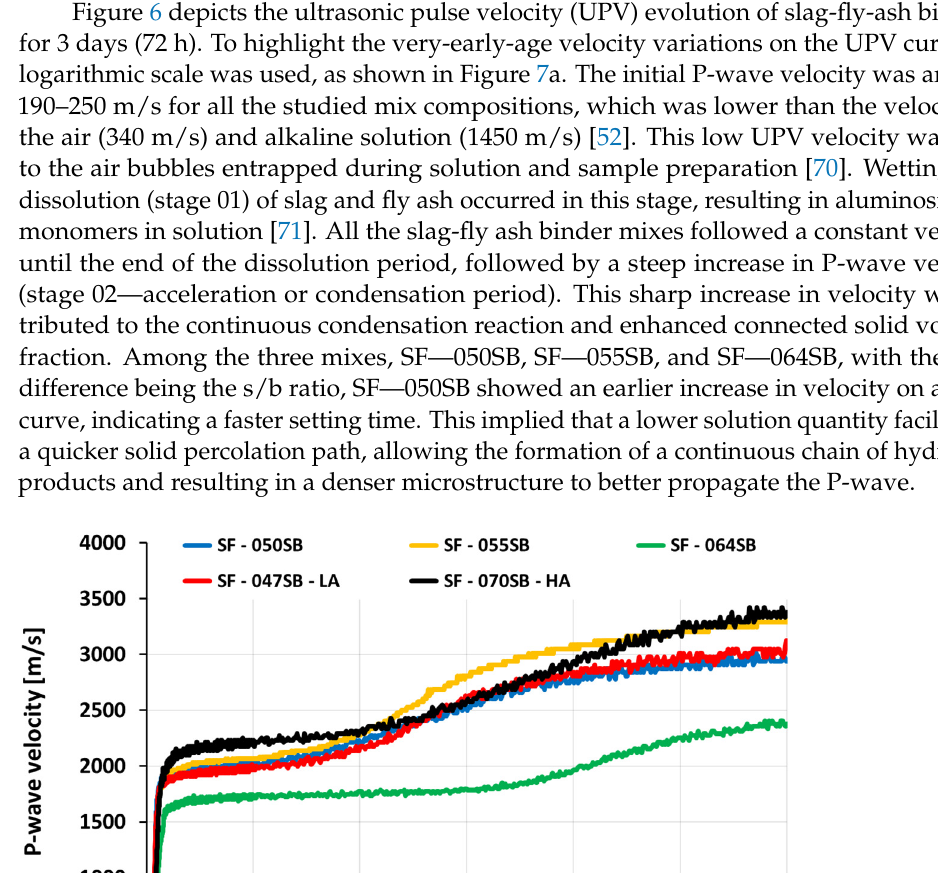
Figure 7. UPV evolution as a function of age: ( a ) all studied mixes in logarithmic scale; ( b ) reference modeled UPV curve for mix